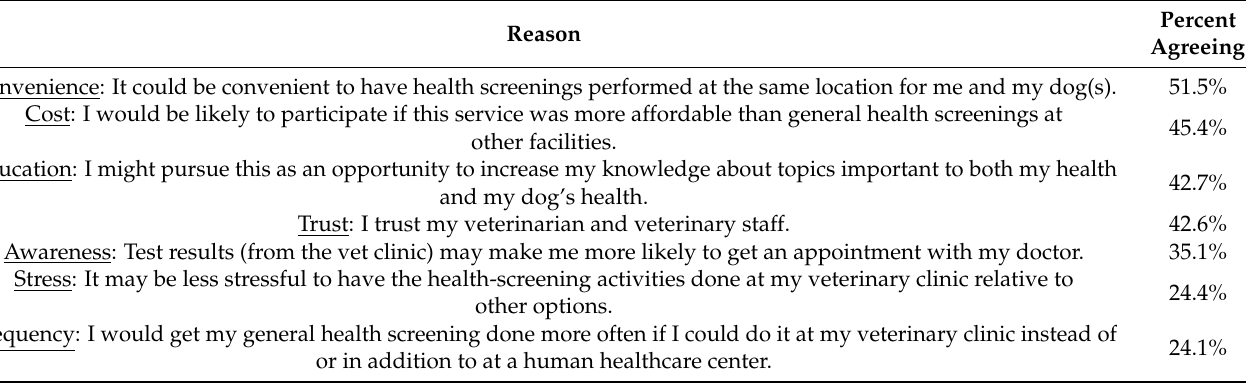
Table 5. Reasons why dog owners (n = 1028) would participate in joint human–animal health activities.